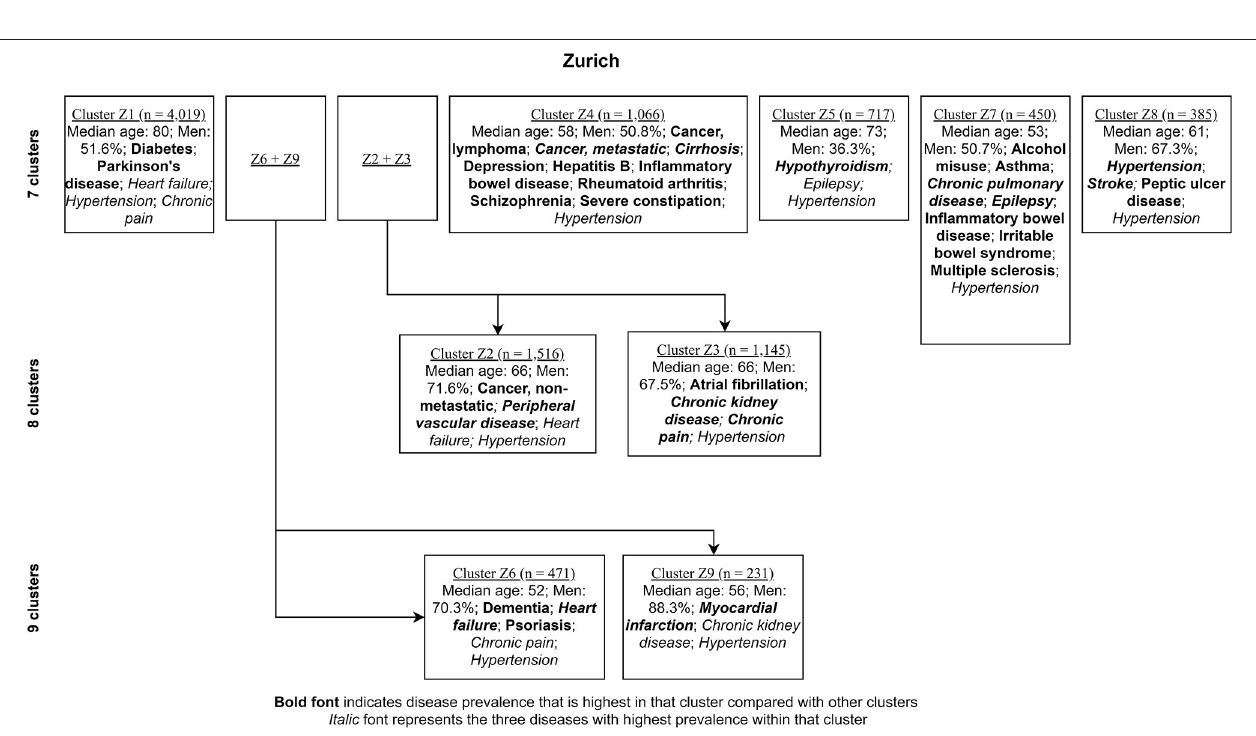
FIGURE 5 | Clustering process (from seven to nine clusters) of Zurich inpatients labeled with characterizing diseases.